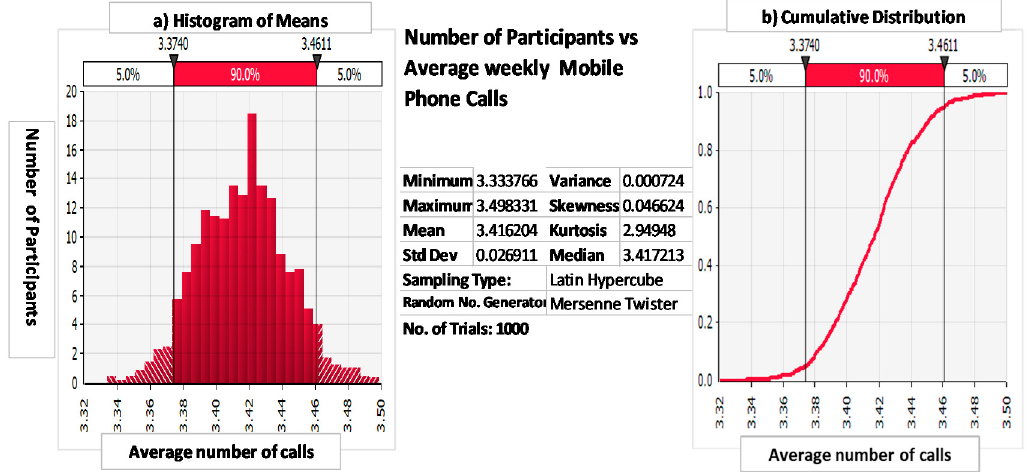
Figure 2. ( a ) Monte Carlo simulation for mean number of calls for trial with n = 163 participants. Depicted is the histogram, plotting number of participants ( y -axis) vs. average weekly mobile phone calls ( x -axis) after n = 1000 trials, and ( b ) cumulative distribution showing risk probability vs. average weekly mobile calls, e.g., x ≤ 3.46 for p = 0. Uncertainty is defined as the confidence interval for the means for a specified level of statistical significance.